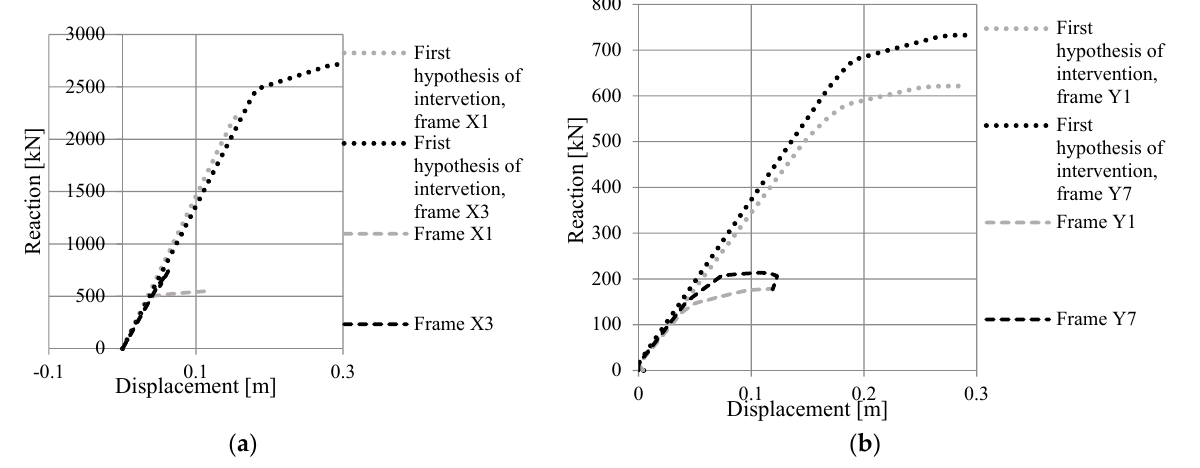
Figure 23. Comparison of pushover curves before and after local intervention in the X -direction ( a ) and the Y -direction ( b ).